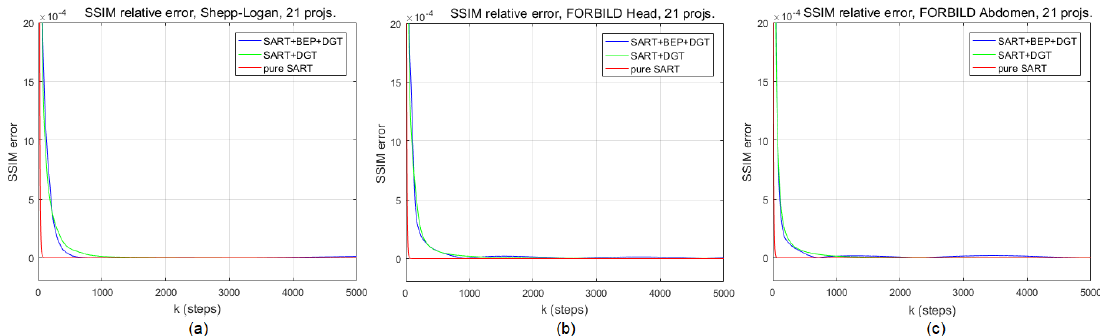
Figure 4. Sructural similarity (SSIM) difference along k iterations, 1 < k ≤ 5000, for pure SART, SART+DGT, and SART+BEP+DGT reconstructions for ( a ) Shepp–Logan head phantom, ( b ) FORBILD head phantom, and ( c ) FORBILD abdomen